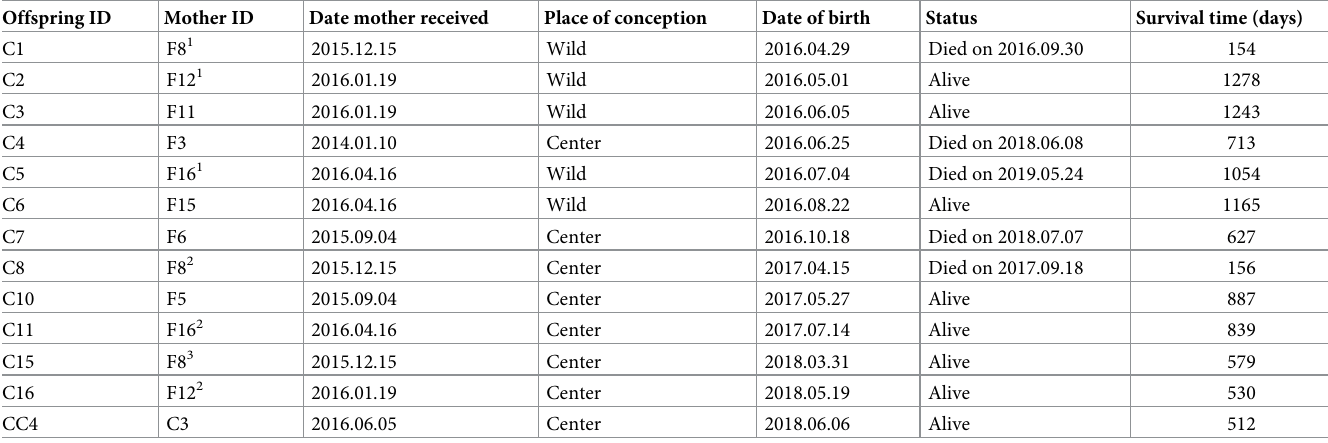
Table 1. Basic information of the 13 Sunda pangolin ( Manis javanica ) offspring and their mothers (recorded until October 31,